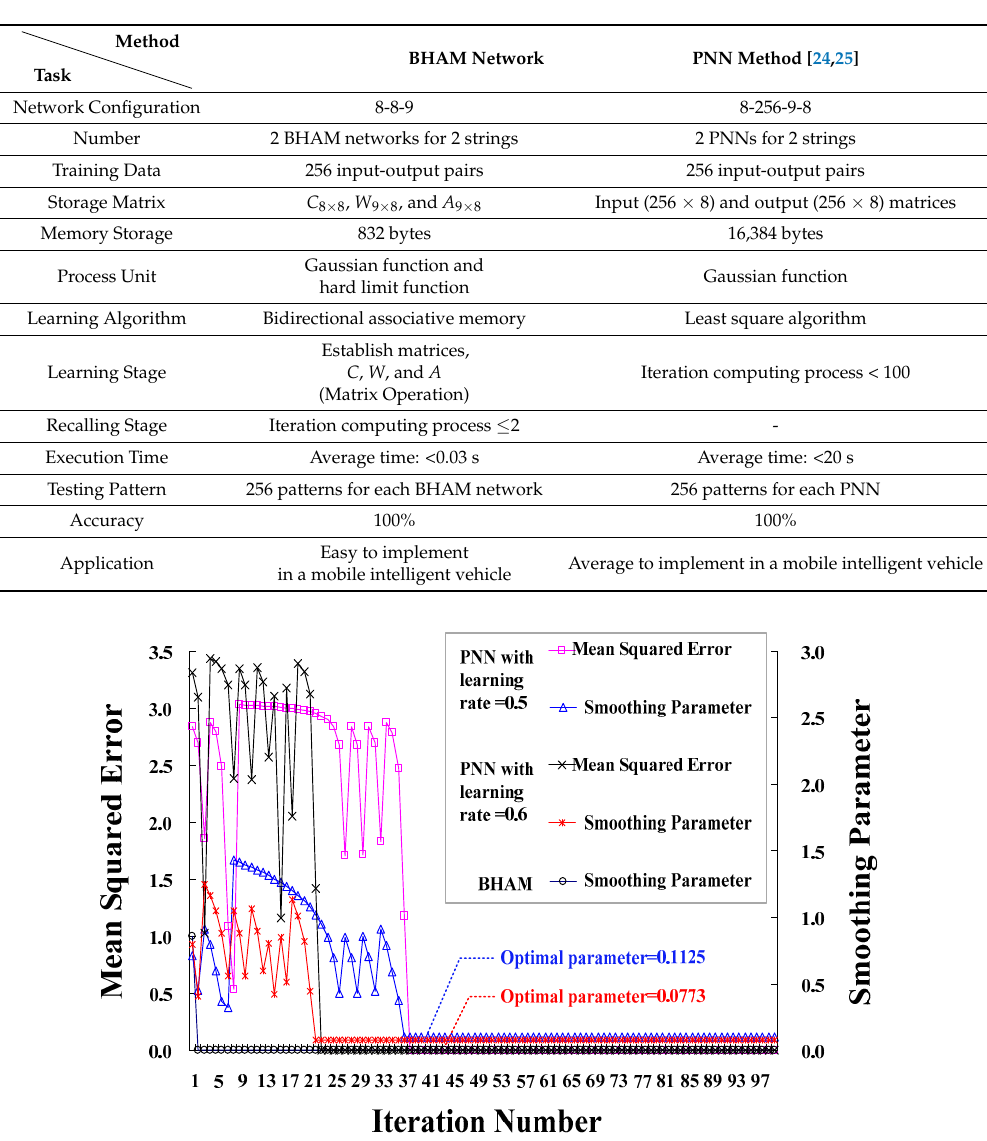
Table 4. Comparison of the proposed model and multi-layer PNN method.